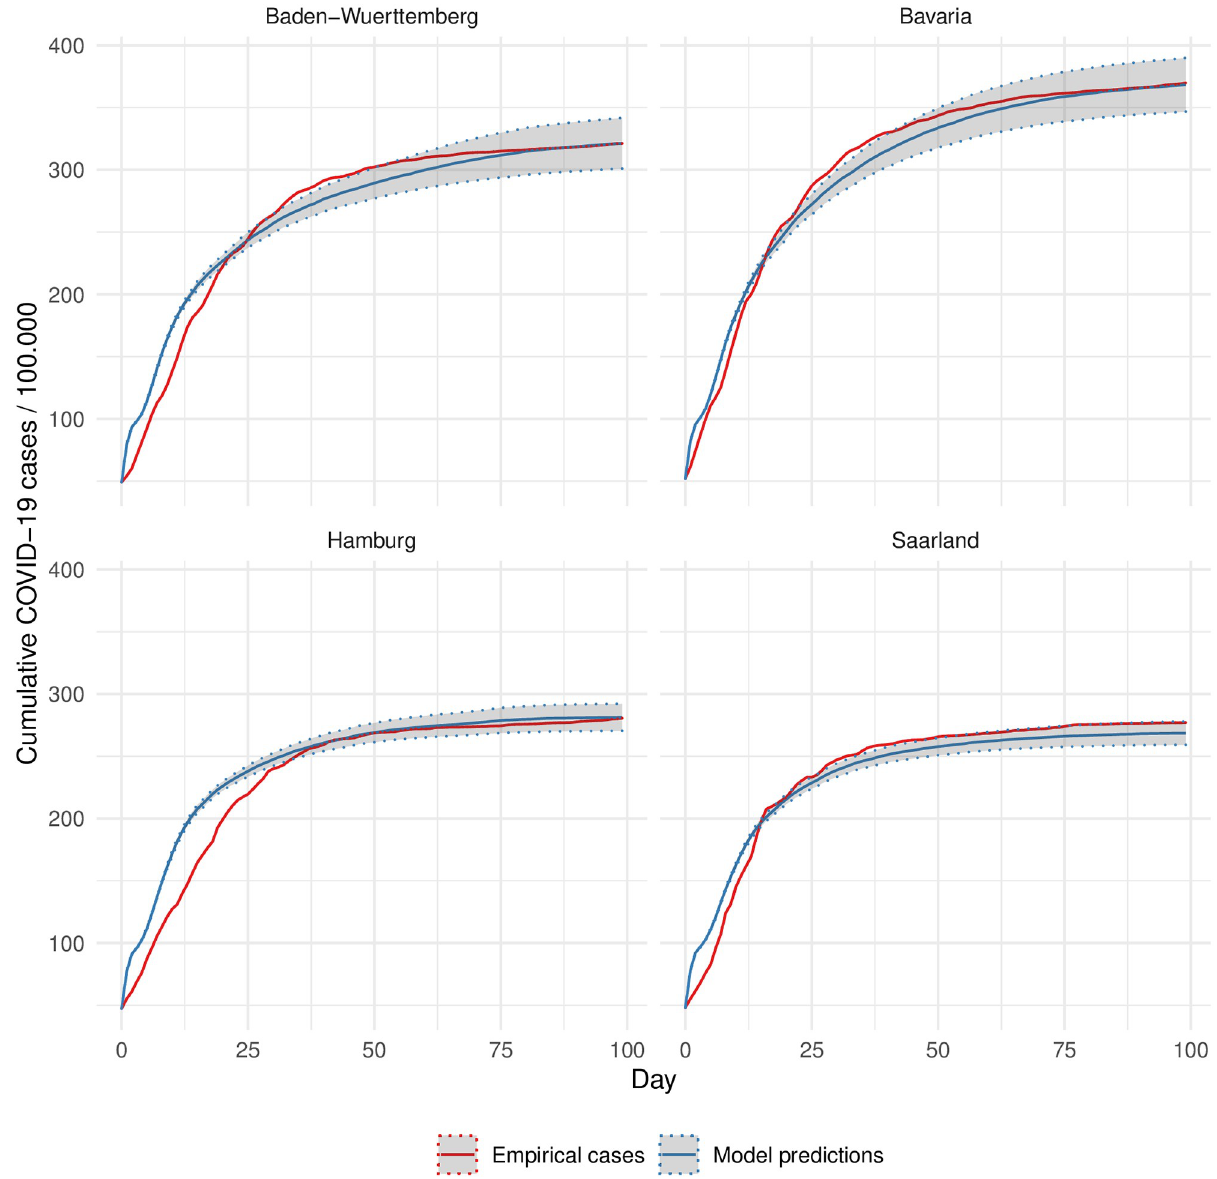
Fig 1. Model fit by state. The solid lines depict the cumulative number of reported COVID-19 cases and the average of cumulative infections across 60 simulation replications per state. Shaded areas represent the 95% confidence intervals of the averages. The root mean squared error of the model’s predictions ranges between 8.414 for Bavaria and 16.56 for